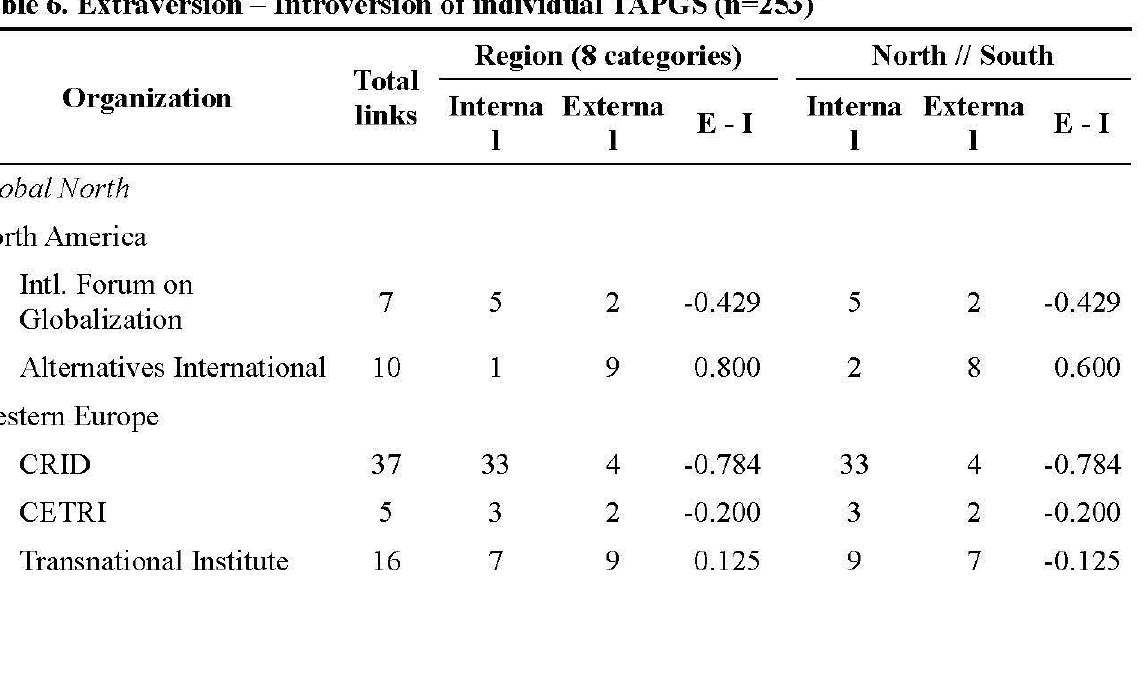
Table 6. Extraversion - Introversion of individual TAPGS